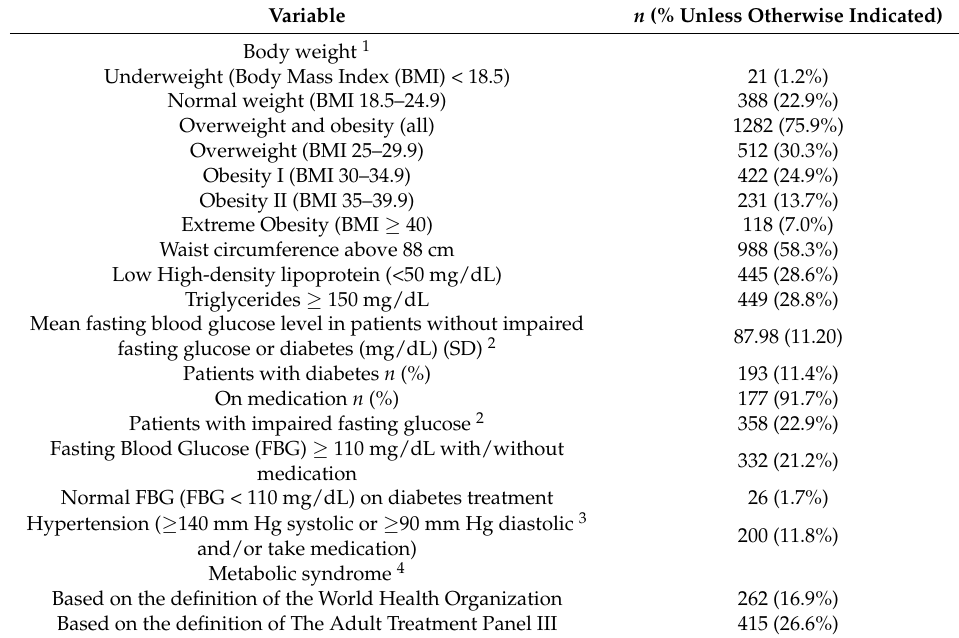
Table 2. Health status of the study sample ( n = 1694) of refugee women (15–84 years), West Bank/Palestine 2010.